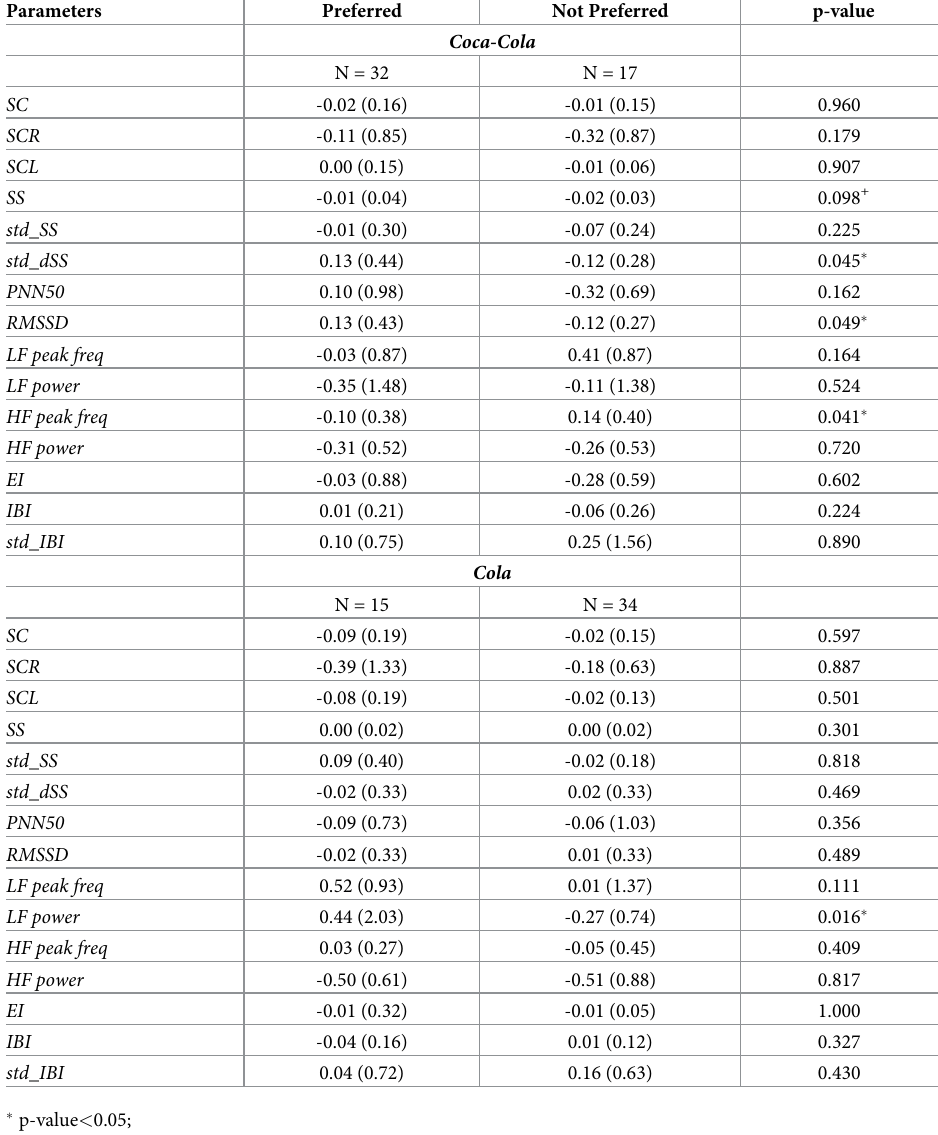
Table 4. Comparison of a beverage when preferred/not